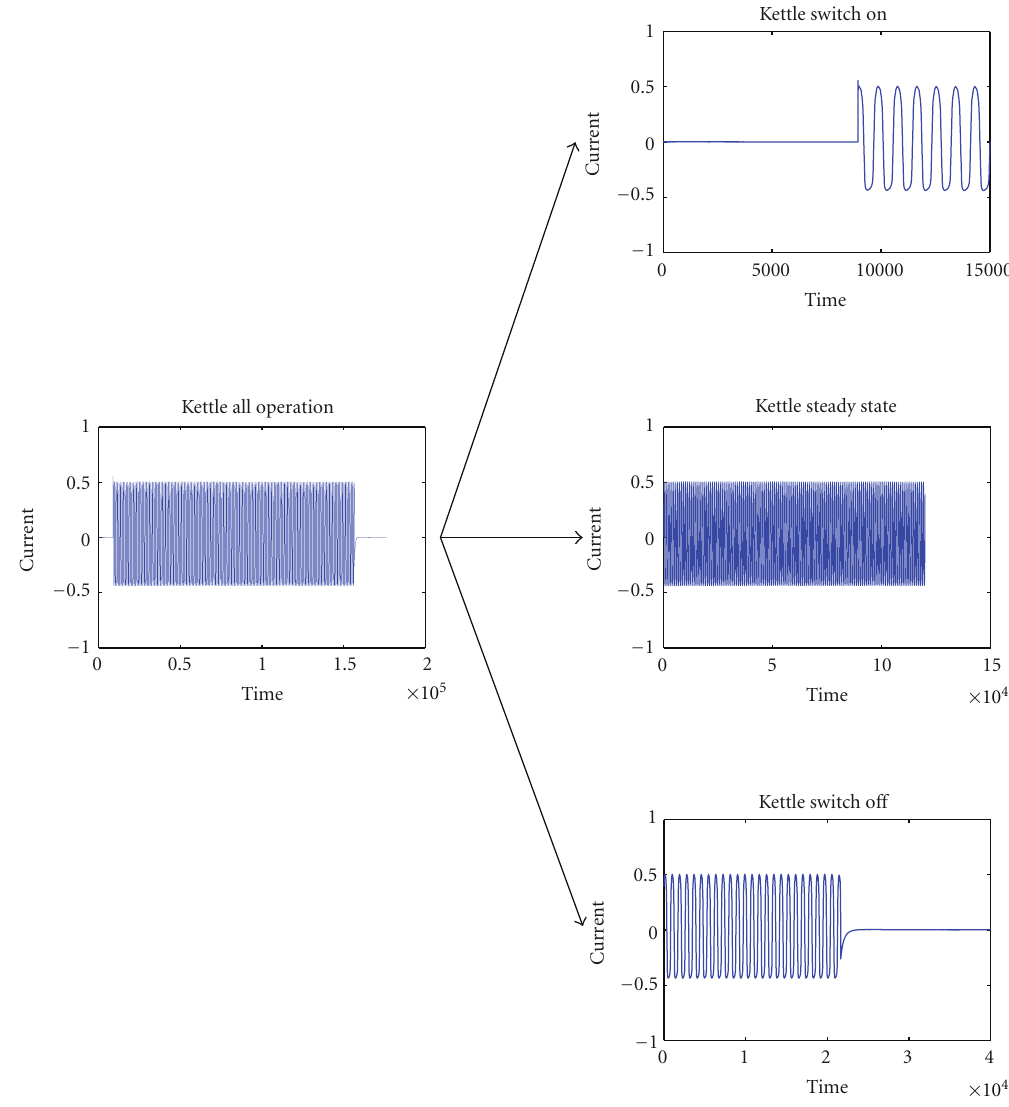
Figure 3: Process of signal